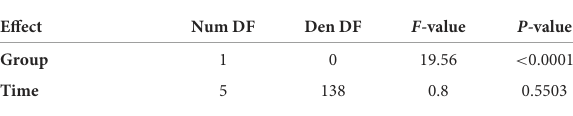
TABLE 4 Mixed-effect model for systemic ventricular EF%.